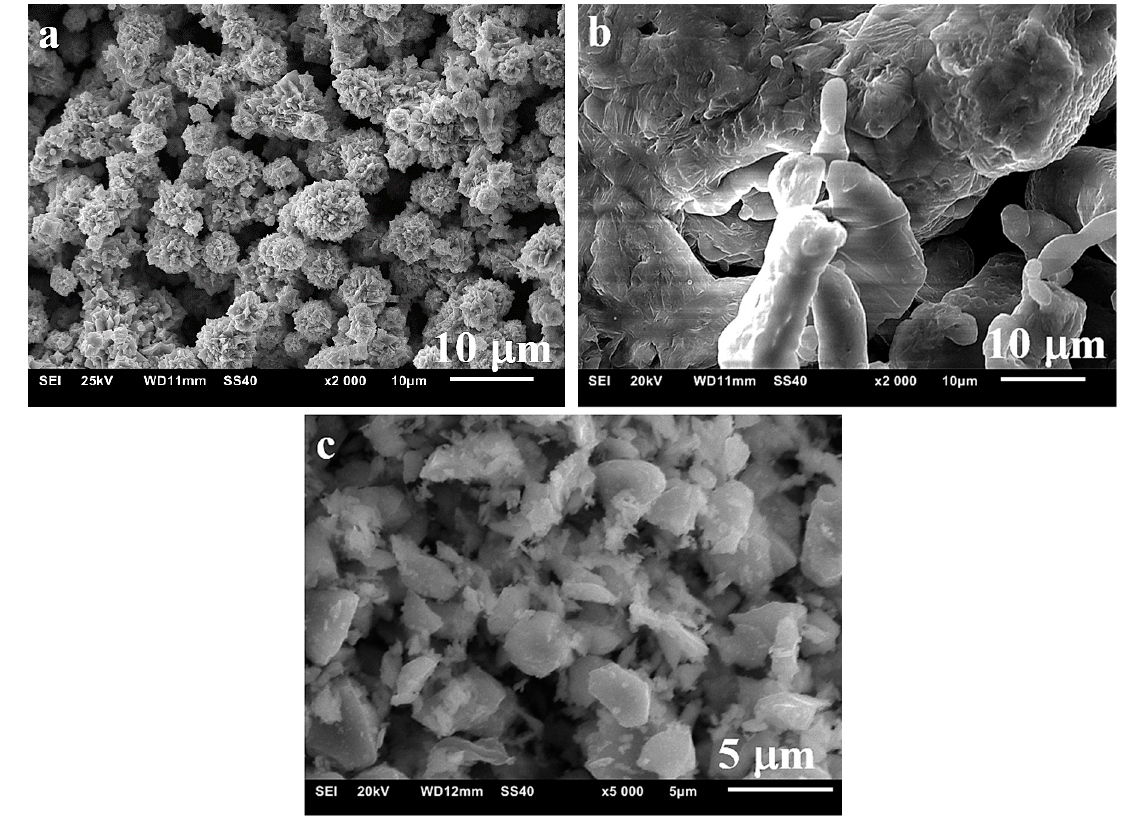
Figure 1. Powder morphology: ( a ) nickel, ( b ) aluminium, ( c ) TiB 2.